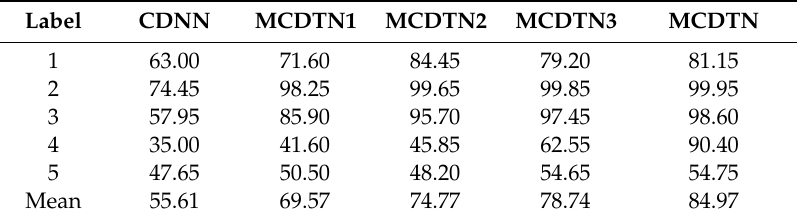
Table 9. The accuracy of DNN and DTNs when the ratio of incomplete data to structurally-complete data is